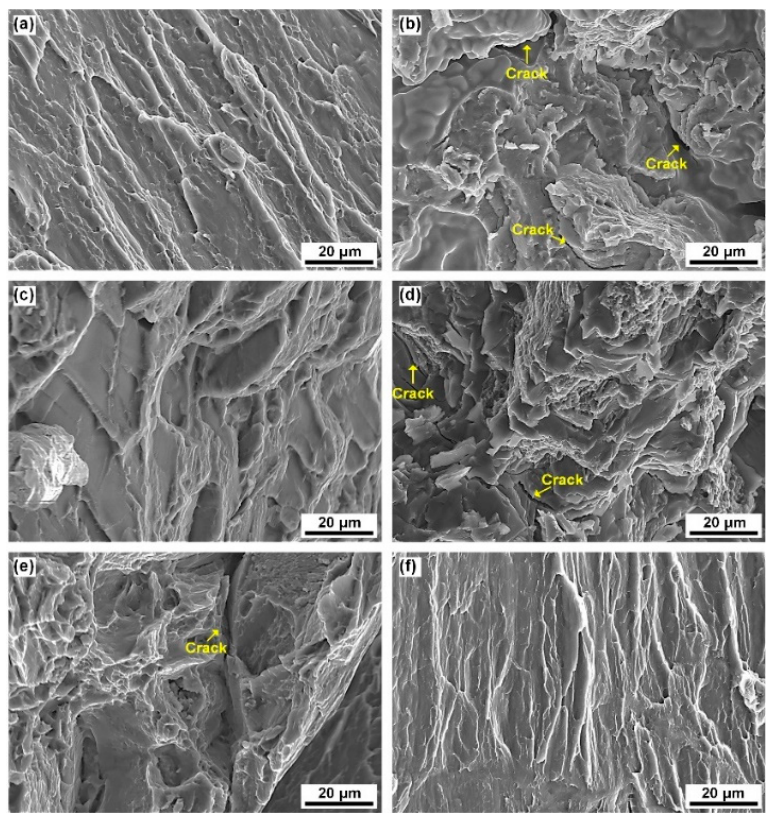
Figure 11. Fracture morphologies of the tensile samples; ( a , b ) laser power at 3 and 5 kW under given welding speed of 1.8 m/min and welding current of 100 A, ( c , d ) welding speed at 1.2 and 2.4 m/min under given laser power of 4 kW and welding current of 100 A and ( e , f ) welding current at 50 and 100 A under given laser power of 4 kW and welding speed of 1.8